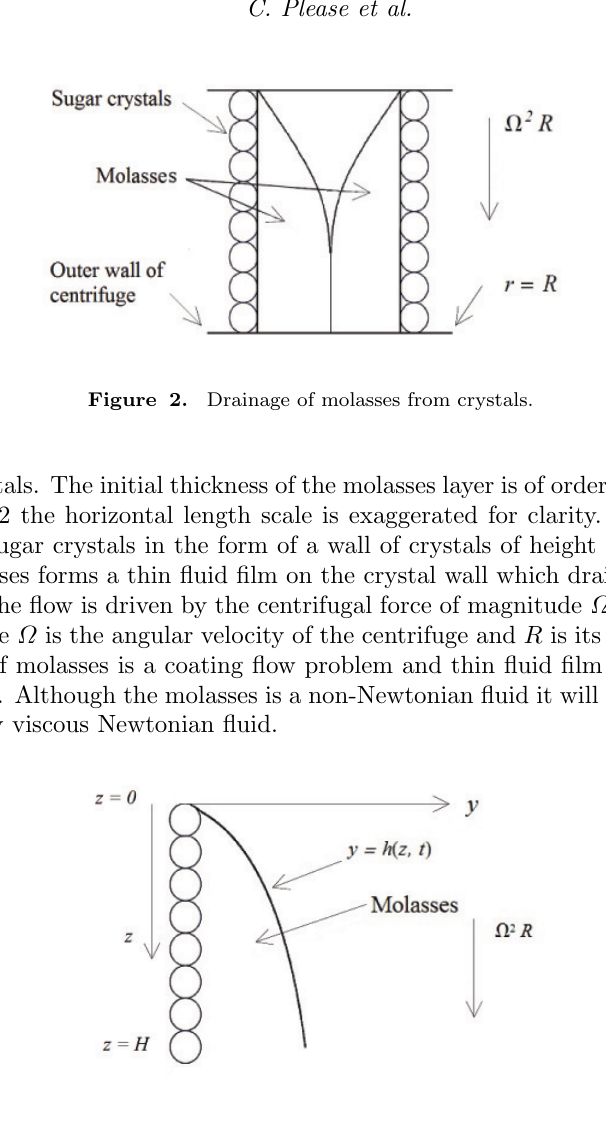
Figure 3. Coordinate system for a thin film of molasses draining from sugar